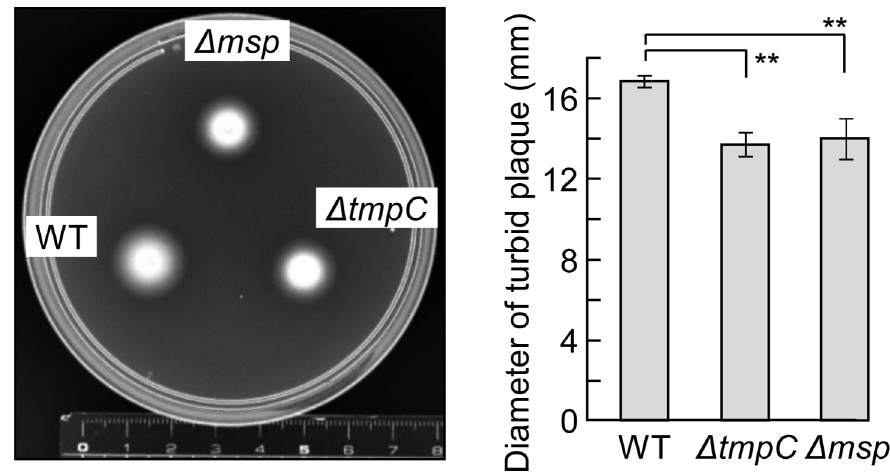
Figure 8. Motility assay. T . denticola strains were seeded on a medium containing 0.5% agar. After the plate was anaerobically incubated at 37 u C for one week, the turbid plaque was measured. Each plate presented is a representative image. The data are expressed as the means 6 SD (n=3). A Dunnett’s test was performed to compare the wild type and mutants (**, P , 0.01).